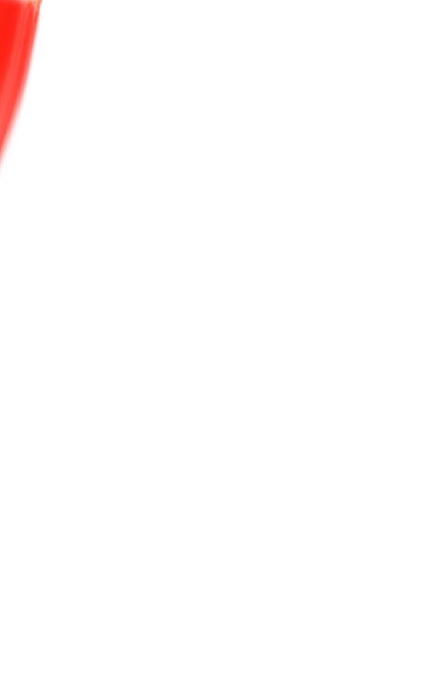
Figure 1. Illustration of popliteal fossa anatomy. Yellow: nerve; blue: vein; red: artery; green: lymph system.